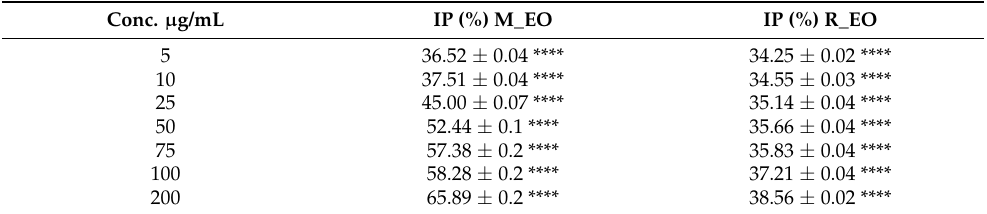
Table 3. The inhibition percentage of Mentha piperita L. and Rosmarinus officinalis L. essential oils at different concentrations (5, 10, 25, 50, 75, 100 and 200 µ g/mL).